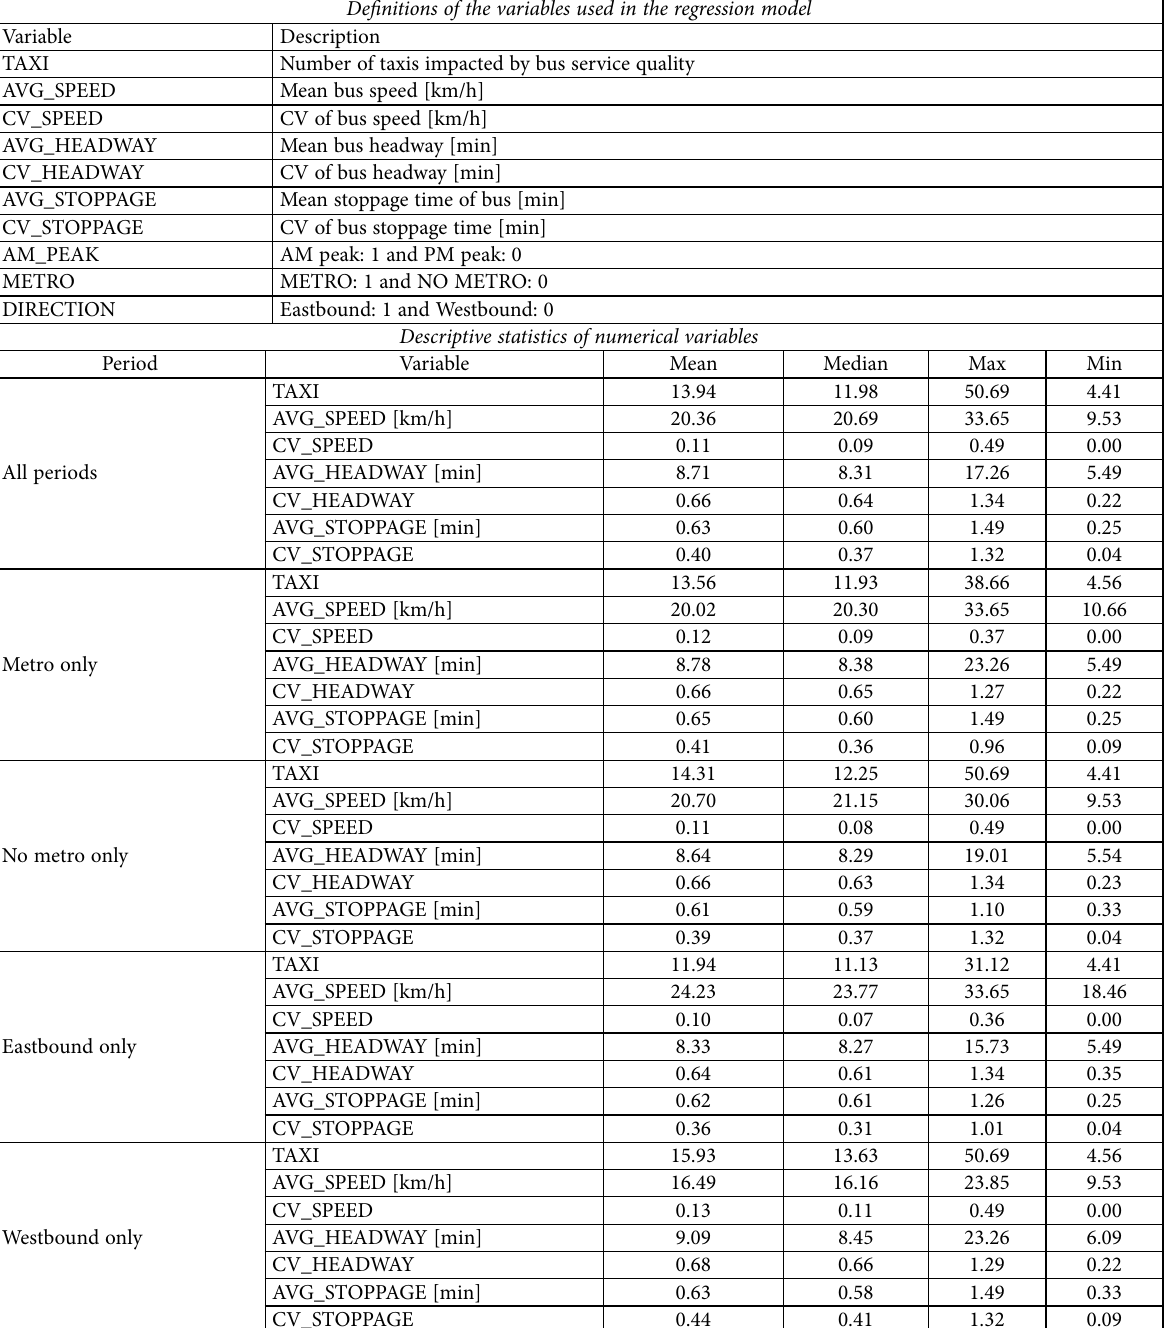
Table 2. Descriptions of selected variables Definitions of the variables used in the regression